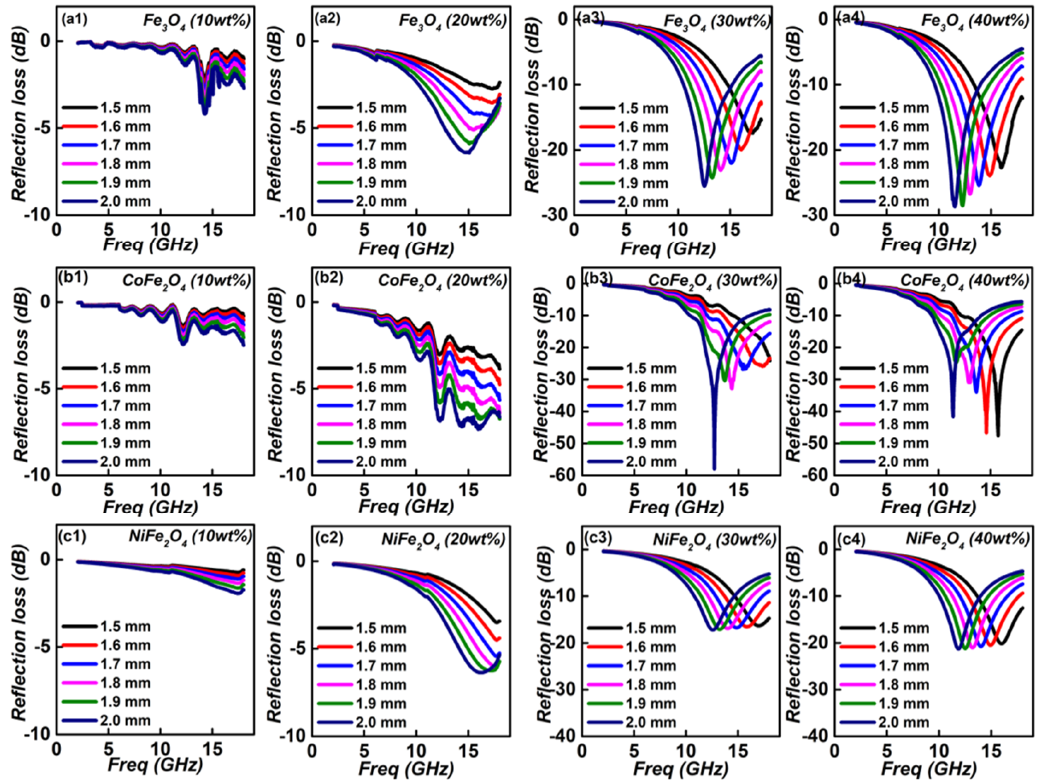
Figure 8. 2D RL maps of Fe 3 O 4 ( a1 – a4 ), CoFe 2 O 4 ( b1 – b4 , c1 – c4 ) NiFe 2 O 4 /paraffin wax composites with different thickness in the frequency range of 2 – 18.0 GHz. Thickness ranges in 1.5 – 2.0 mm. In comparison with Fe 3 O 4 , the minimum RL value of CoFe 2 O 4 absorption layer equals to −57.8 dB with a matched thickness of 2.0 mm. Meanwhile, the maximum effective ab- sorption region is estimated to be 6.2 GHz under identical 1.8 mm. As for the NiFe 2 O 4 , the optimized RL value and effective absorption region respective −17.1 and 4.2 GH, and cor- responding thickness are 2.0 and 1.8 mm. But continues increases to 40 wt%, minimum RL value and effective absorption band do not enhance significantly. To comprehensively consider the bandwidth, thickness and filling ratio, the absorption layer made with 30% of Fe 3 O 4 would be the optimized electromagnetic performance. Compared with the ferrite- based EM materials in recent advances (listed in Table 1), it is clearly the Fe 3 O 4 -paraffin wax exhibited the excellent within a lower filling ratio. Table 1. Ferrites based electromagnetic absorption performance according to recent advances. Samples